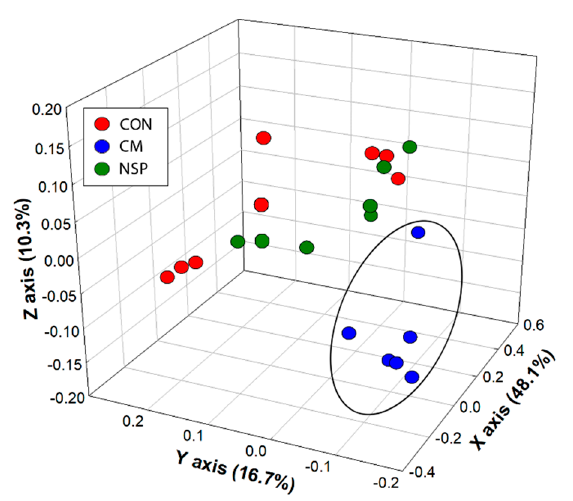
Figure 4. Unweighted UniFrac principal coordinate analysis of cecal communities within mini-bioreactor vessels containing the basal medium (CON), the basal medium with cold press extracted canola meal (CM), and the basal medium with non-starch polysaccharides extracted from canola meal (NSP). Replicate vessels were combined for Illumina characterization of bacterial communities. The ellipsoid illustrates clustering of bacterial communities for the CM treatment, relative to communities for the NSP and CON treatments.